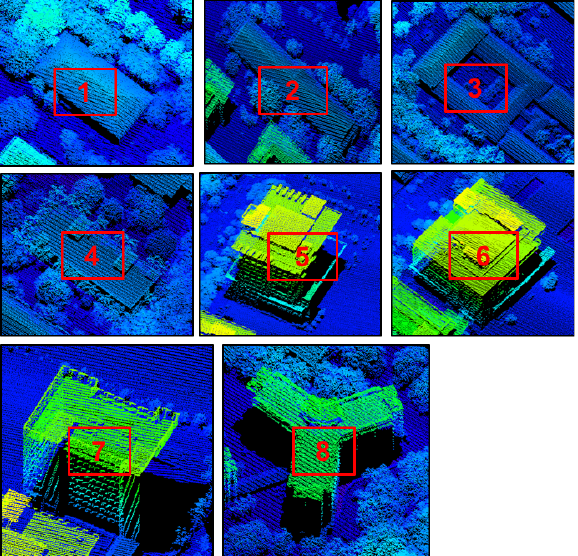
Figure 12. All of the point cloud datasets with respect to the sequence of the test